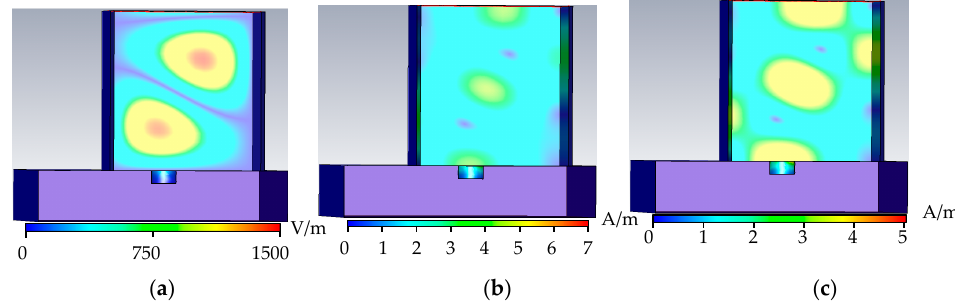
Figure 9. Cylinder defect field distribution. ( a ) Cylinder defect electric field distribution. ( b ) Cylinder defect magnetic field distribution. ( c ) Cylinder defect wall current distribution.